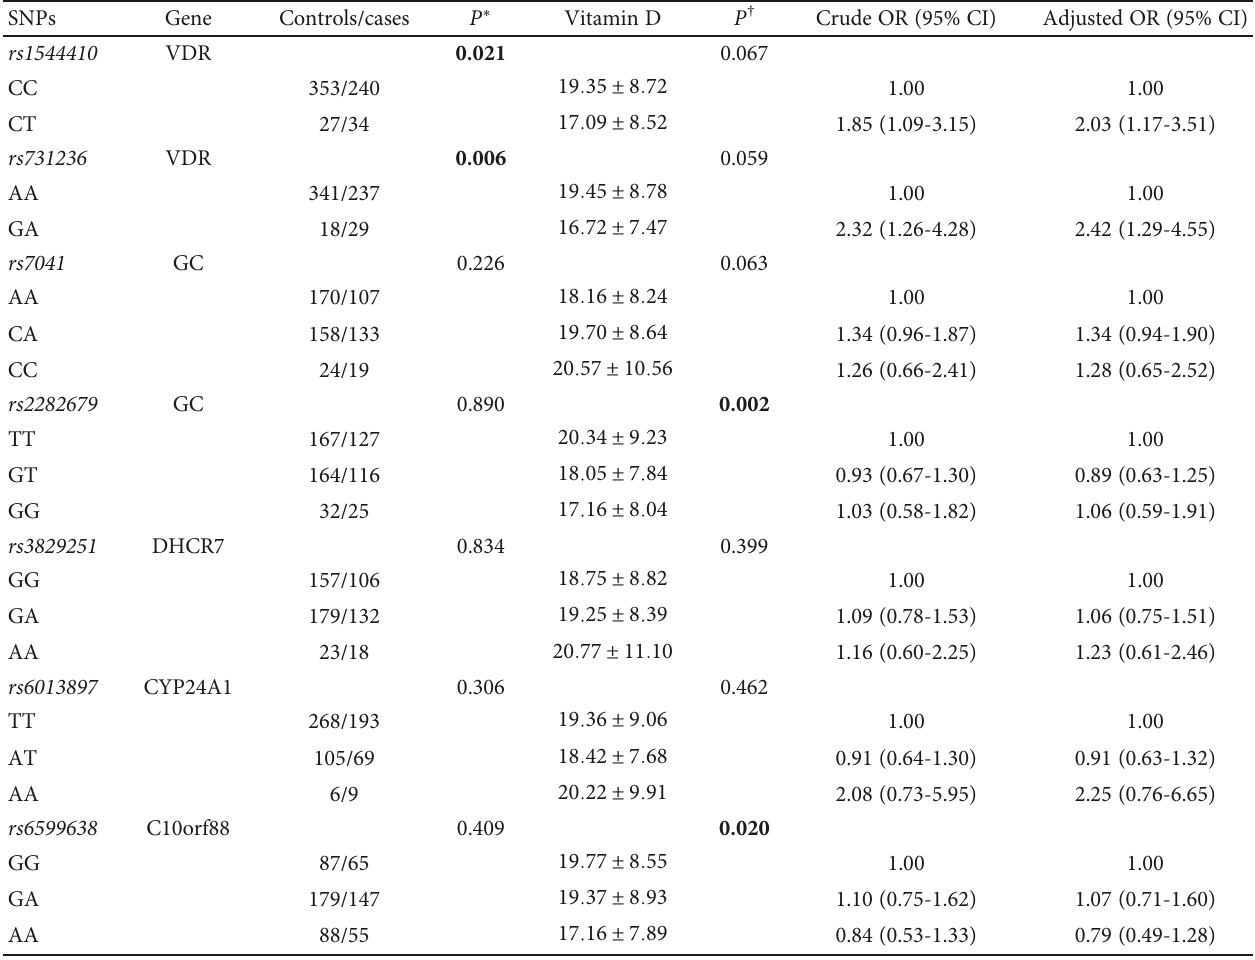
Table 3: The association between SNPs in vitamin D metabolism genes and the risk of